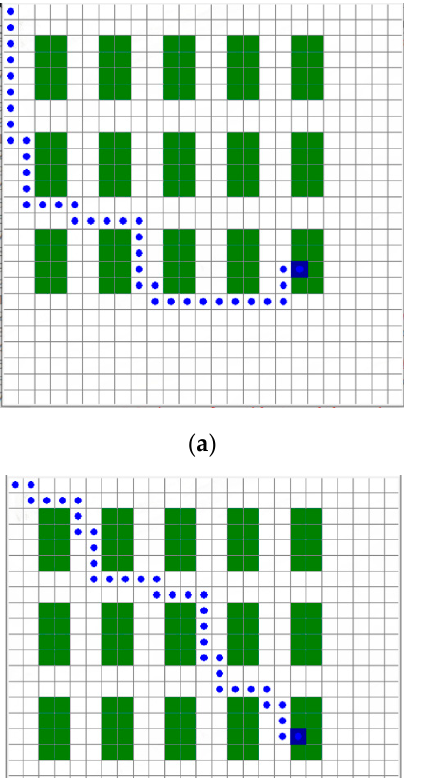
Figure 14. Path optimization learning progress status of Q-Learning with action based reward: ( a ) 1st test; ( b ) 2nd test; ( c ) 3rd test; ( d ) 4th test; ( e ) 5th test.